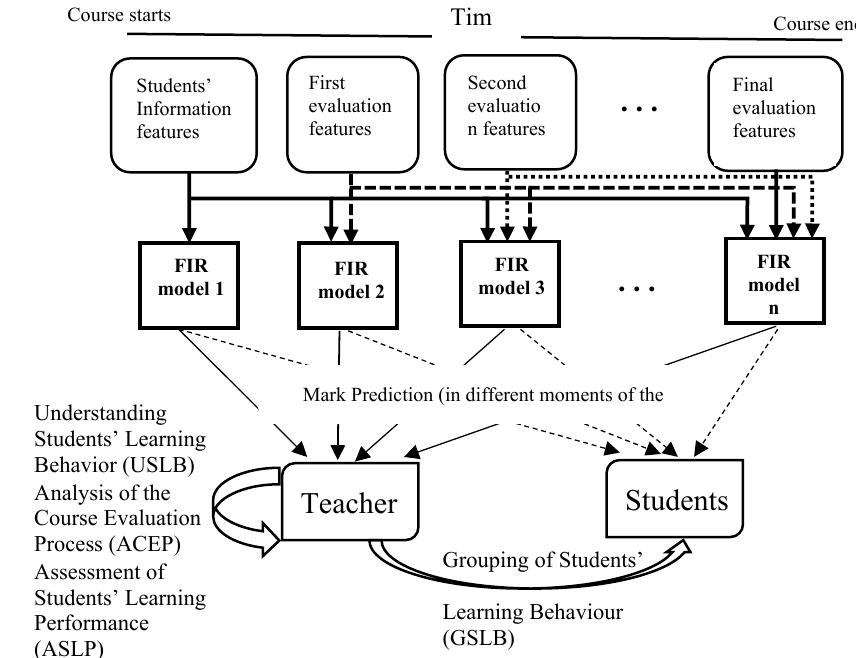
Figure 2. Dynamic strategy of ASLP, GSLB, USLB, and ACEP functionalities. FIR = fuzzy inductive reasoning.